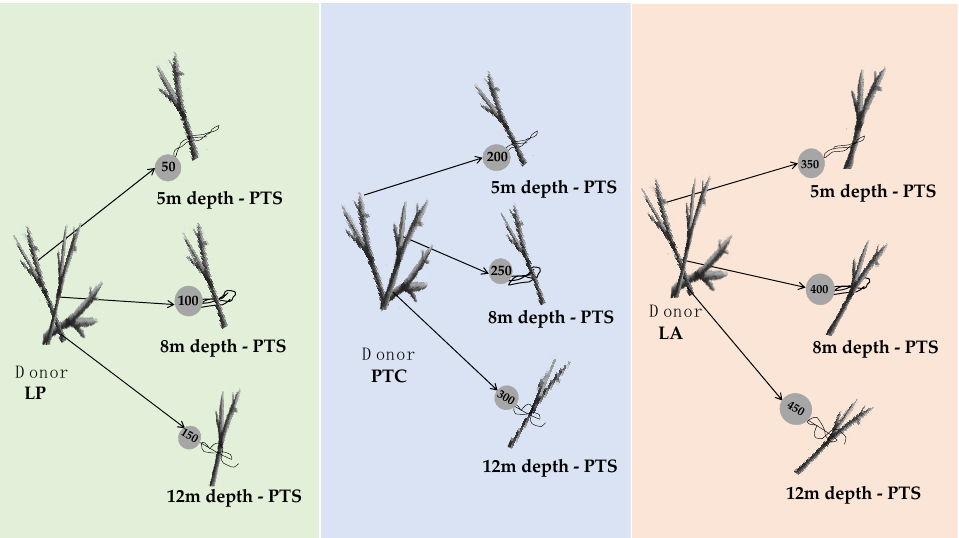
metal rods, each 2 × 0.02 m, to the sandy bottom, forming a five-pointed star with one central rod and the remaining five rods (hereafter the “ peripheral rods ” ) set 2 m apart from the central rod, Figure 3A – C. The peripheral rods were connected to the central rods by two sets of fishing line, one at 1.5 m above the sandy bottom and the other at 1.0 m. In total, nine five-pointed star coral farms were installed, three per depth. Coral farms at each depth were set 20–30 m apart from each other. A total of 50 fragments per farm were attached to the fishing lines for a grand total of 450 fragments. Notice that every donor colony have a clone fragment at each depth and that no more than one clonal fragment from the same donor colony was placed at the same depth, Figure 2.